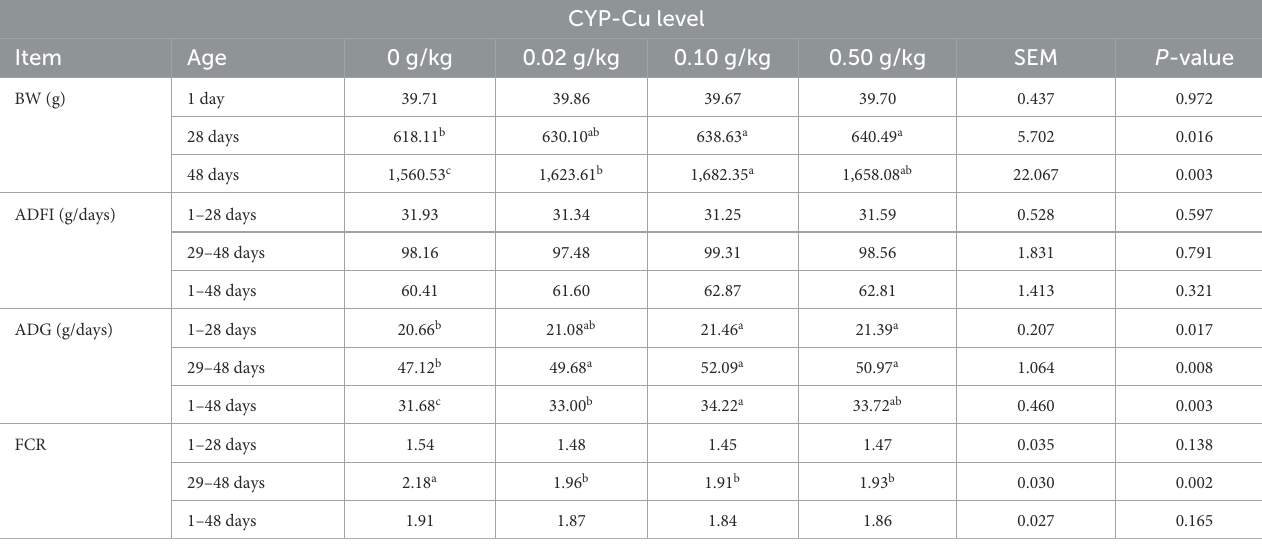
TABLE 3 Effect of dietary CYP-Cu on the growth performance in broilers.